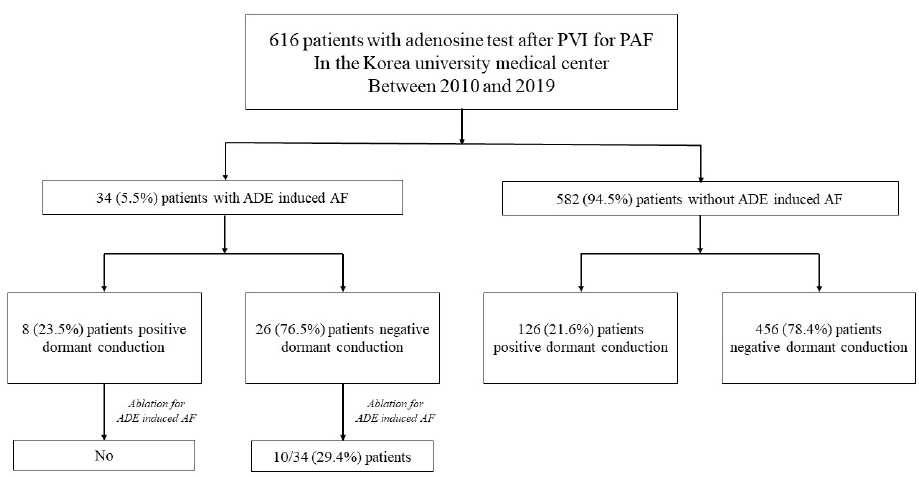
Figure 1. Flowchart showing the study design. PVI = Pulmonary vein isolation; PAF = paroxysmal atrial fibrillation; ADE = adenosine.